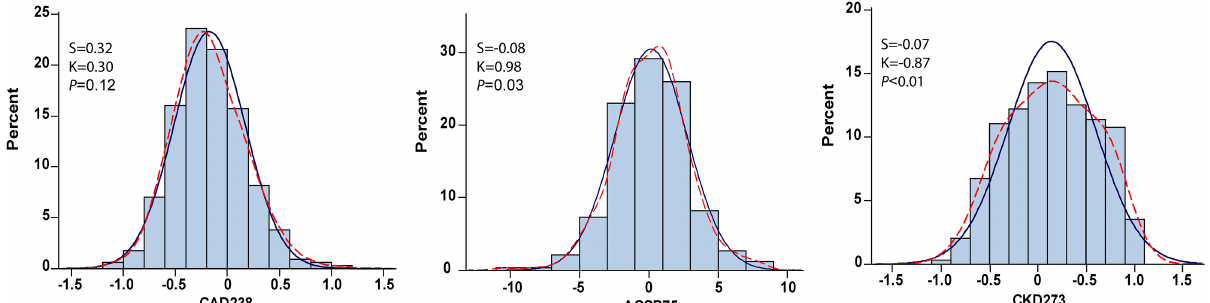
Fig 3. Distributions of the multidimensional urinary proteomic classifiers CAD238,ACSP75 and CKD273,consisting of 238, 75 and 273 urinary peptide fragments and designed for diagnosis and prognostication in the frameworkcoronary heart disease (CAD238and ACSP75)or chronic kidney disease (CKD273). The P value is for departureof the actually observeddistribution(kernel distribution;dotted line) from normality(full line).